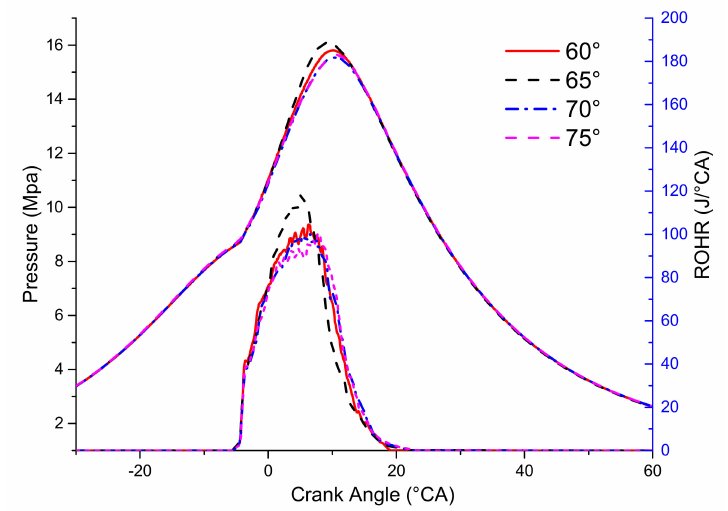
Figure 17. In-cylinder pressure and heat release rate at di ff erent nozzle